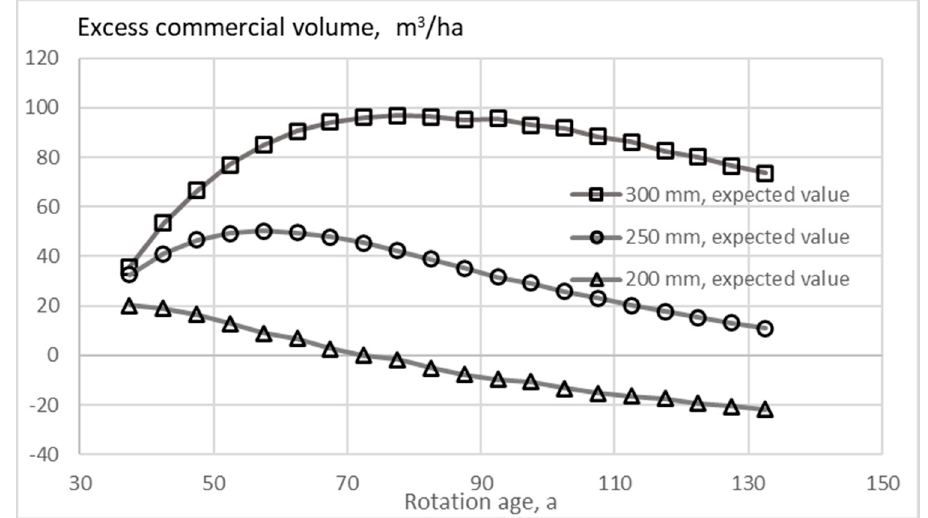
Figure 7. Excess commercial stem volume per hectare, in comparison to the treatment schedule corresponding to the greatest expected value of capital return rate. The three curves correspond to three di ff erent cutting diameter limits (200 mm, 250 mm, and 300 mm).